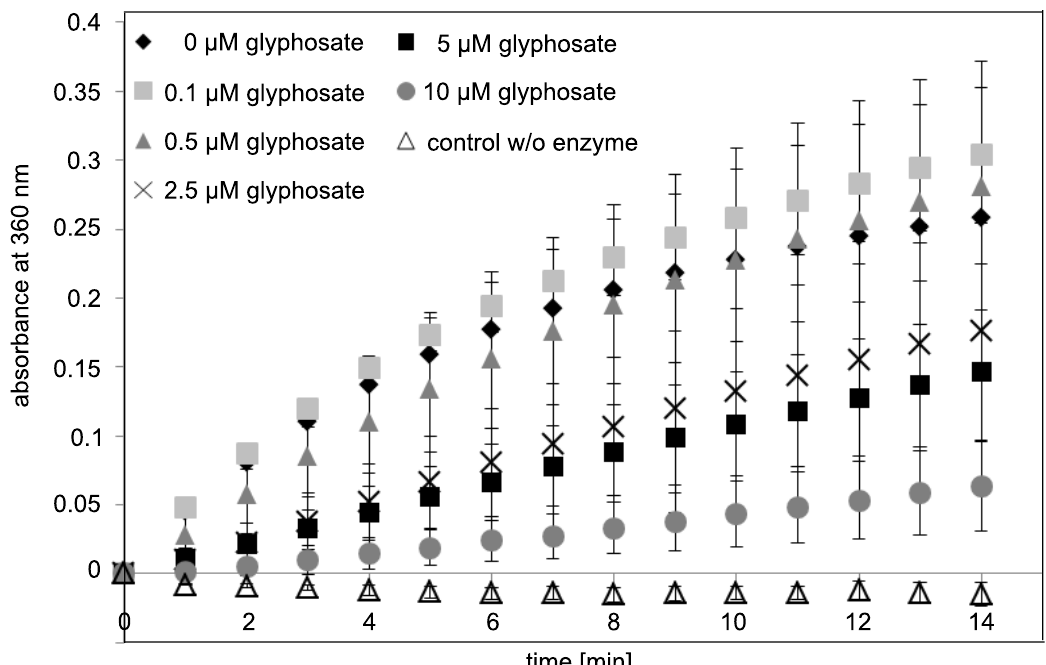
Figure3. ActivitymeasurementofCcg2_GS_EcEPSPS(0.05 µ